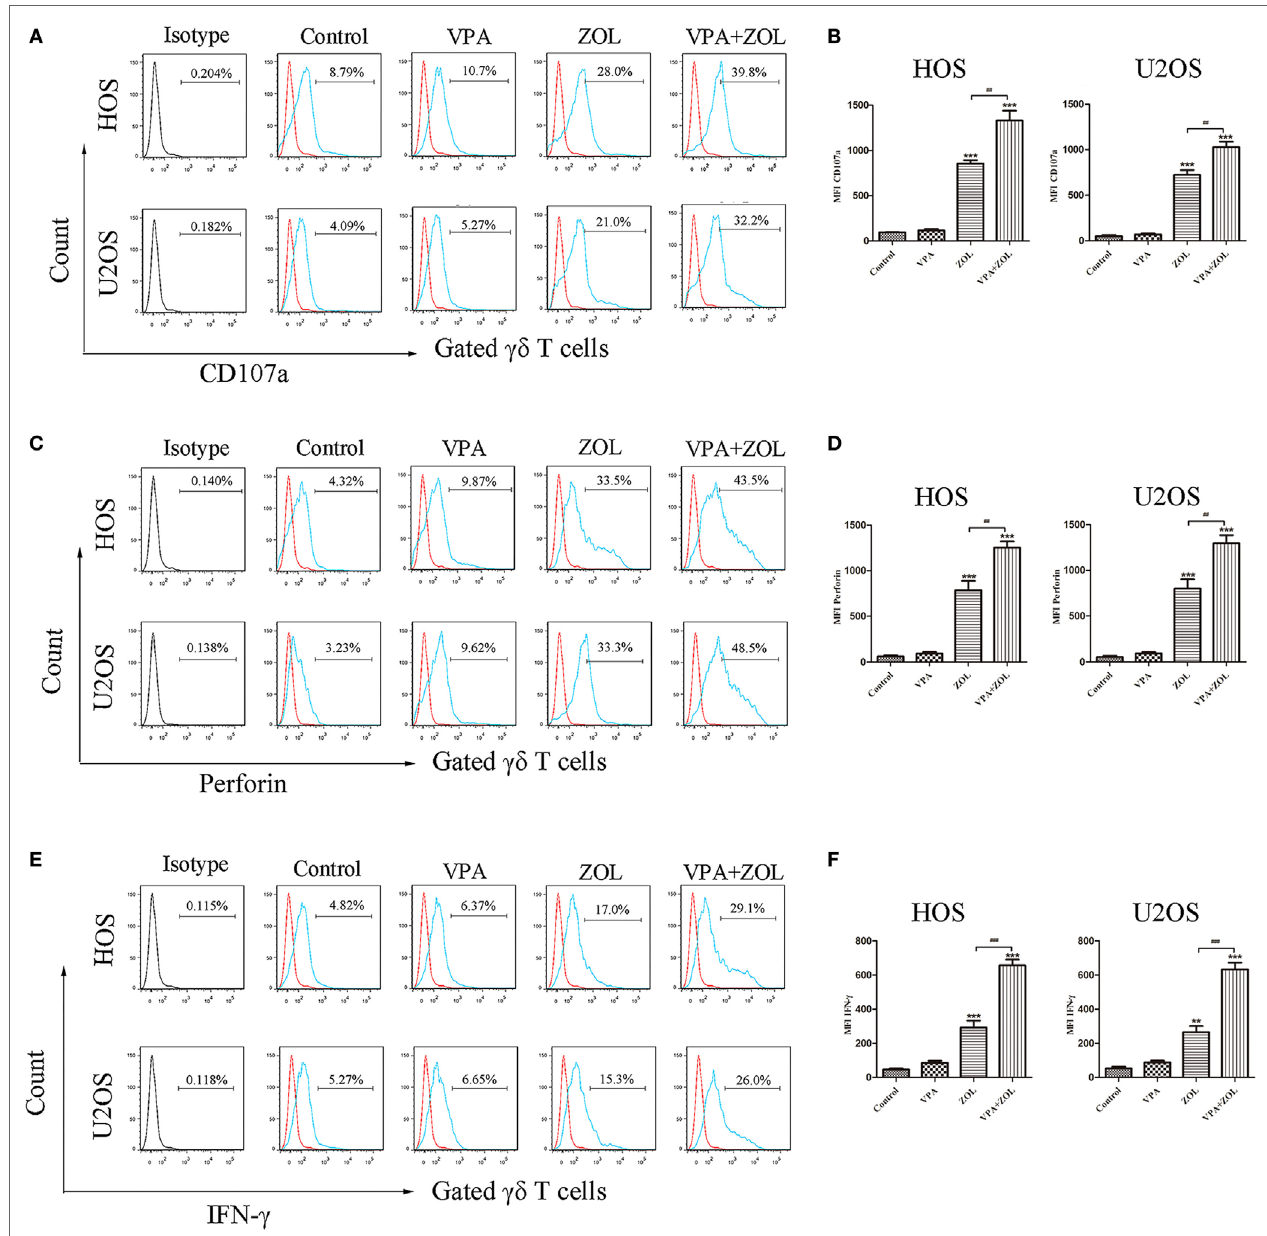
FigUre 2 | Valproic acid (VPA) and zoledronate (ZOL) upregulated the level of γδ T cells cytotoxicity-related indicators against osteosarcoma cells. HOS and U2OS cells were treated for 24 h with control, 1 mM VPA, 2 µM ZOL, and VPA + ZOL, respectively, before 2 h co-cultured with γδ T cells at an E:T ratio of 5:1. (a,B) CD107a expression levels on γδ T cells were measured by flow cytometry. MFI of CD107a + γδ T cells was presented in histograms. (c,D) Perforin expression levels of γδ T cells were measured by flow cytometry. MFI of perforin + γδ T cells was presented in histograms. (e,F) IFN- γ expression levels of γδ T cells were measured by flow cytometry. MFI of IFN- γ + γδ T cells was presented in histograms. Red histogram line was isotype control and panels were overlapped. All the values were shown as mean ± SD from three independent experiments; * p < 0.05, ** p < 0.01, *** p < 0.001 versus control, # p <